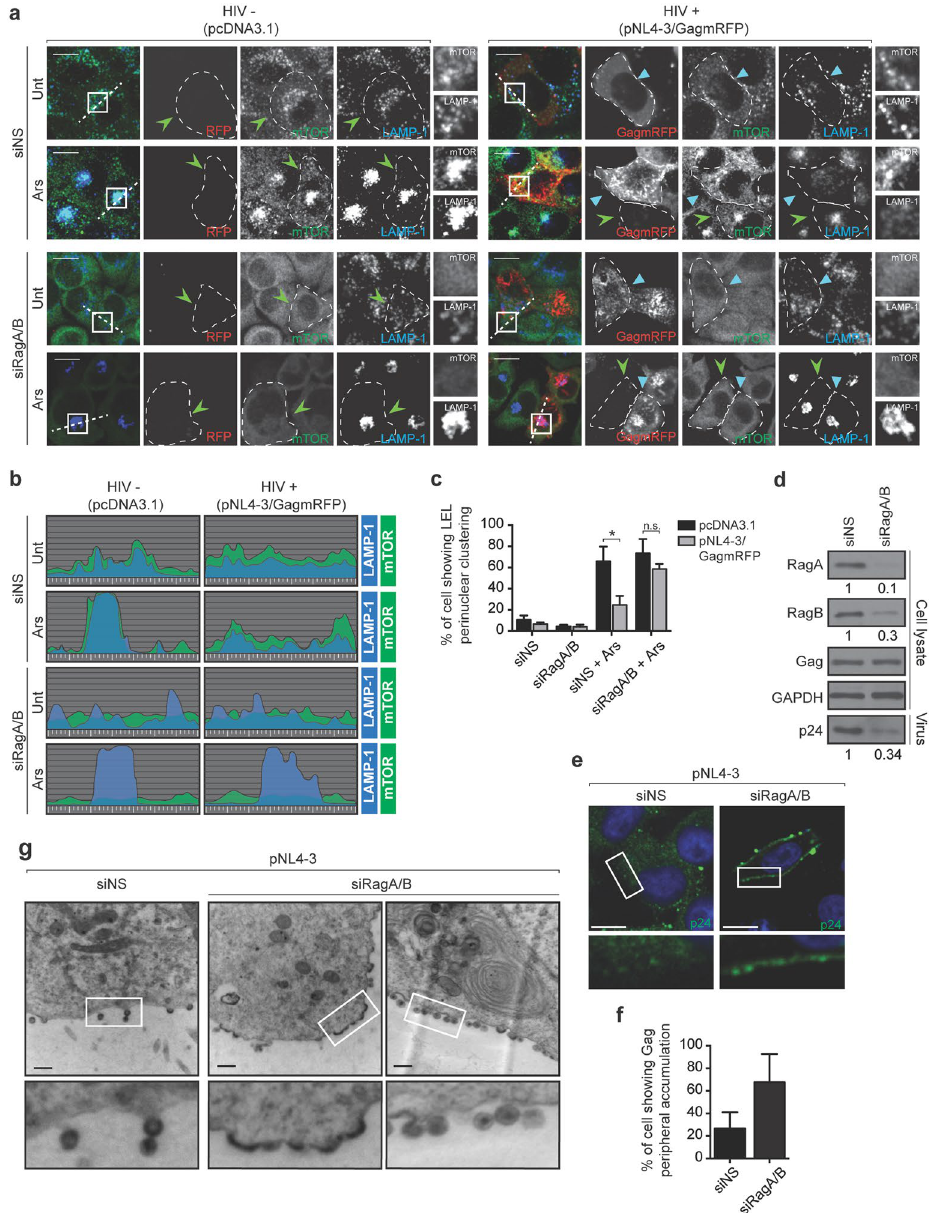
Figure 5. RagA and RagB are necessary for HIV-1 to control LEL trafficking and for the viral budding and release. ( a ) HeLa cells, treated with non-silencing (NS) siRNA or siRNAs targeting RagA and RagB mRNAs, were transfected with empty vector control, pCDNA3.1 or HIV-1 using pNL4-3/GagmRFP, and then mock treated or treated with Ars. Cells were stained for mTOR (Cell Signaling 7C10) and LAMP-1. Light blue arrowheads identify HIV-1-expressing cells, while HIV-1-negative cells are indicated with green arrowheads. A dashed line contours individual cells. Scale bars are 10 μ m. ( b ) The graphs represent the fluorescence intensities of mTOR (green) and LAMP-1 (blue) across the dashed lines from panel a. ( c ) The percentage of mock or HIV-1-transfected cells showing perinuclear clustering of LEL from panel a. The results are presented as the mean ± S.D. from three different experiments. P value is indicated by * (p < 0.05); n.s.: no signifcant difference between the means. ( d ) HeLa cells were co-transfected with the HIV-1 pNL4-3 and either non- sense (NS) siRNA or siRNA against RagA and RagB. HIV-1 particles were collected from the supernatant after filtration and ultracentrifugation. Cell lysates and virus particles were separated by SDS-PAGE, transferred to nitrocellulose and probed with the indicated antibodies. siRNA-mediated fold changes in RagA, RagB and virus production are indicated below insets in panel d in this representative experiment. Full-length blots are shown in Supplementary Fig. 5. ( e ) HeLa cells were co-transfected with the HIV-1 pNL4-3 and either non-sense (NS) siRNA or siRNA against RagA and RagB. Cells were fixed 24 h after transfection and stained for p24. ( f ) The percentage of HIV-1 and siRagA/B transfected cells showing peripheral accumulation of Gag from e. The results are presented as the mean ± S.D. from three different experiments. ( g ) HeLa cells were transfected as in e and subjected to transmission electron